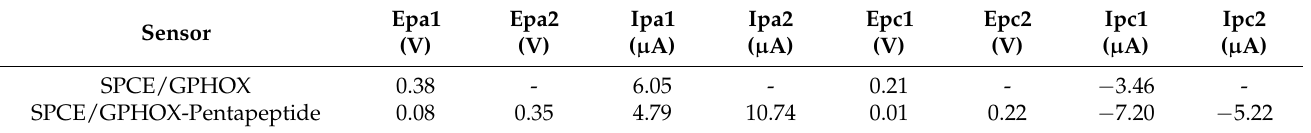
Table 2. The values of the parameters obtained from the CVs of the two sensors immersed in 10 − 4 M verbascoside-0.1 M PBS solution of pH 6.5.